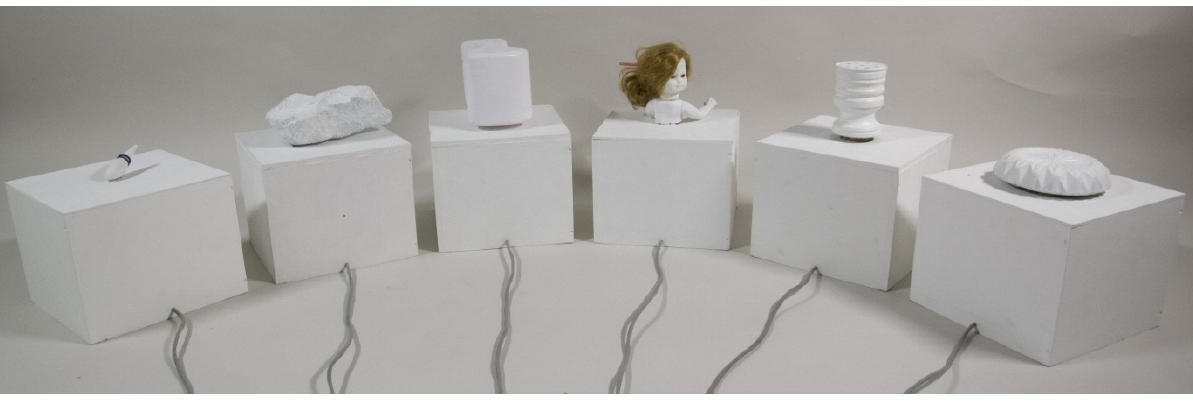
Figure 8. All six prototypes, from left to right: 1 , 2 , 3 , 4 , 5 , and 6